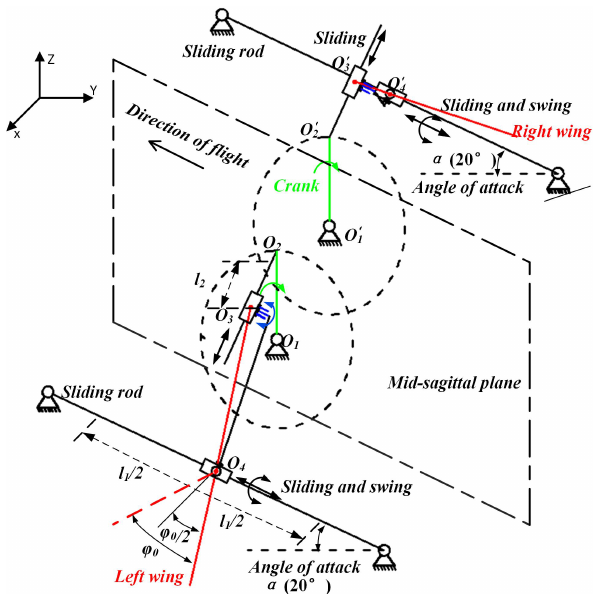
Figure 3. Schematic illustration of